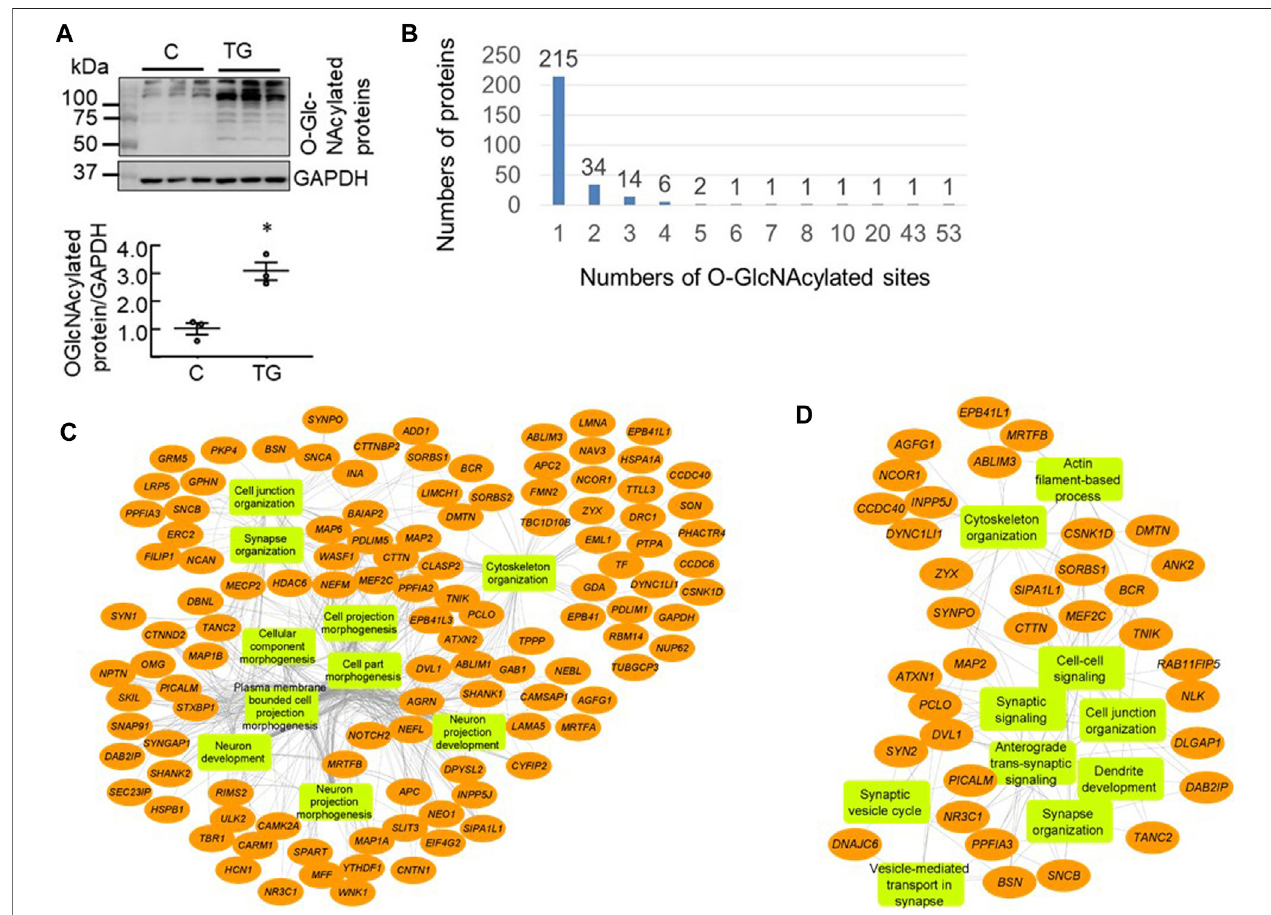
FIGURE 1 | Proteomics analysis of mouse cortical O-GlcNAcome (A) Western blot analyses with cortical protein extracts demonstrated that 3 h post i. p. Thiamet G (TG) injection at 10 mg/kg, there was an increase of overall levels of protein O-GlcNAcylation (quanti fi ed using the entire lane) as detected by the CTD110.6 antibody ( n (cid:1) 3,* p < 0.05Studentt-test) (B) UsingisobarictandemmasstaglabellingcombinedwithCEPCmethodweidenti fi ed506peptidescorrespondingto278proteinsthat were O-GlcNAcylated in the mouse cortex ( n (cid:1) 3 for control and n (cid:1) 2 for TG). Of these, 215 proteins have one modi fi cation site, 34 proteins have two sites, 14 proteins have 3 sites, six proteins have four sites, two proteins have fi ve sites, and one protein each has 7, 8, 10, 20, 43, and 53 sites (C , D) Network visualization of the top 10 Gene Ontology biological process terms enriched for the total 278 O-GlcNAcylated proteins identi fi ed in both Saline and TG groups (C), and the 65 proteins that exhibited signi fi cant increases in O-GlcNAcylation levels following acute TG treatment (D) .